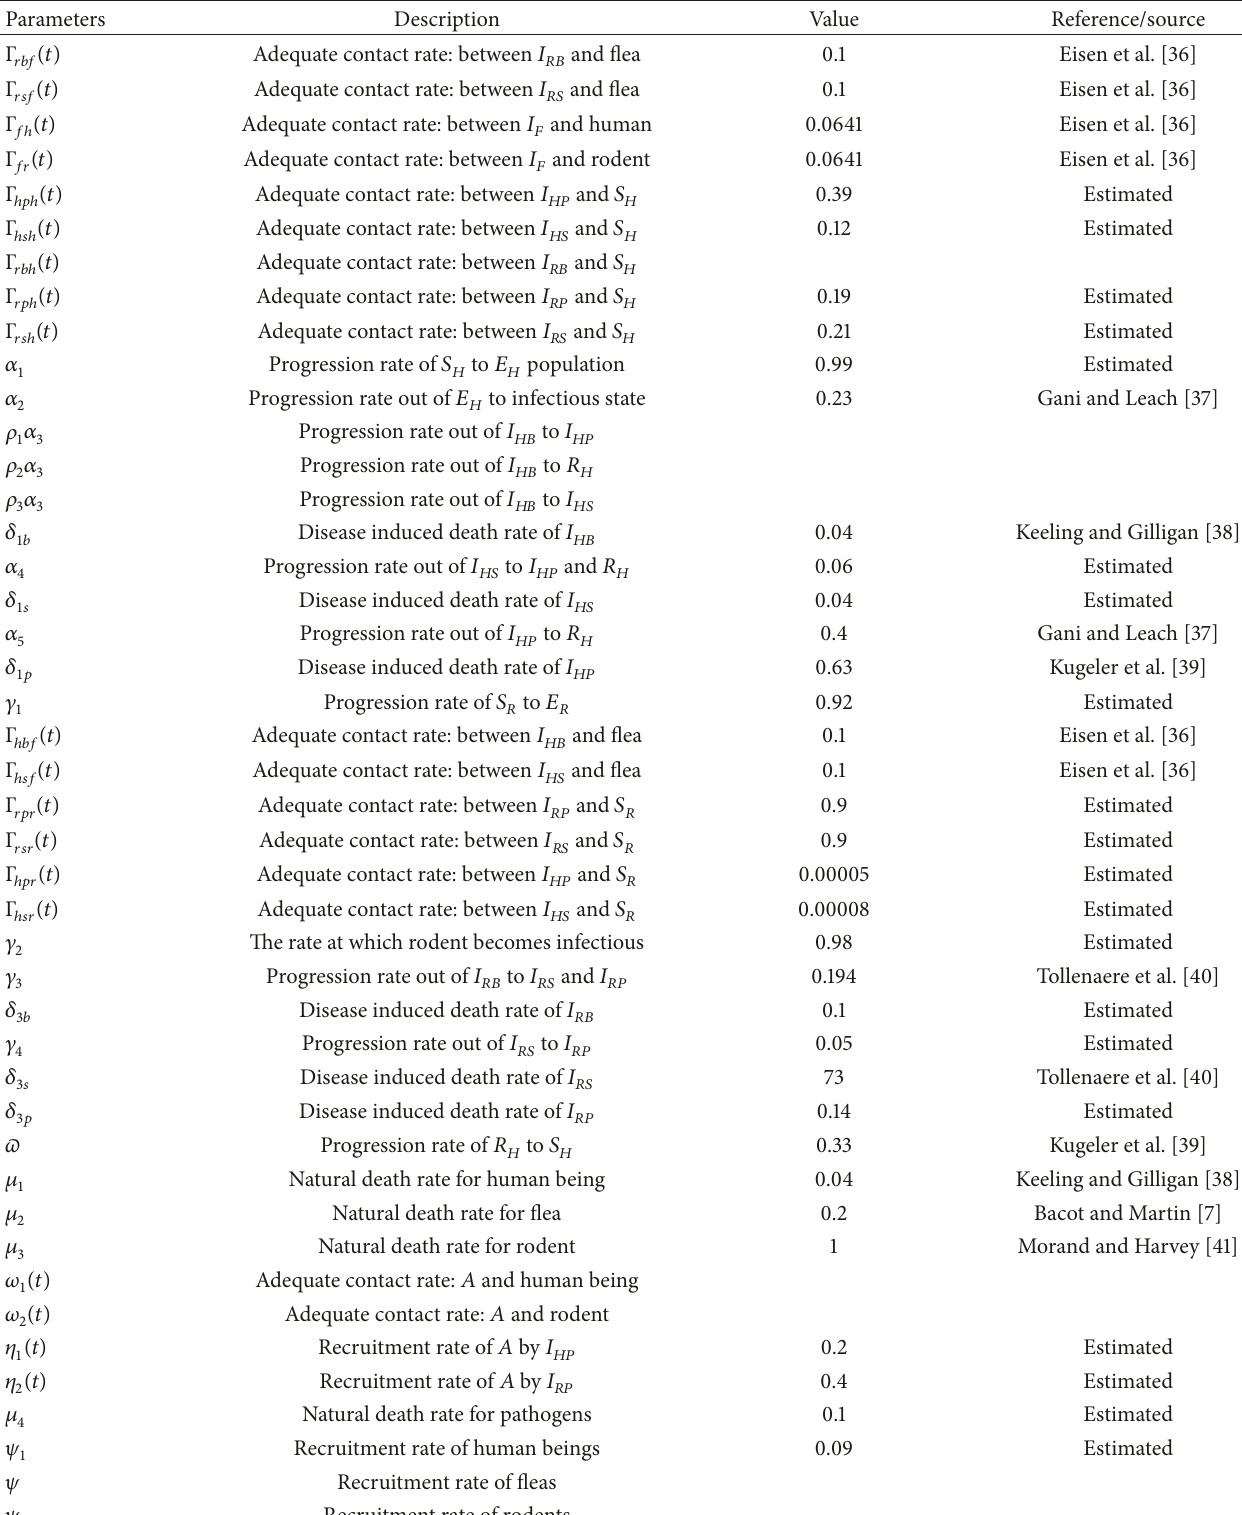
Table 1: Parameters and their